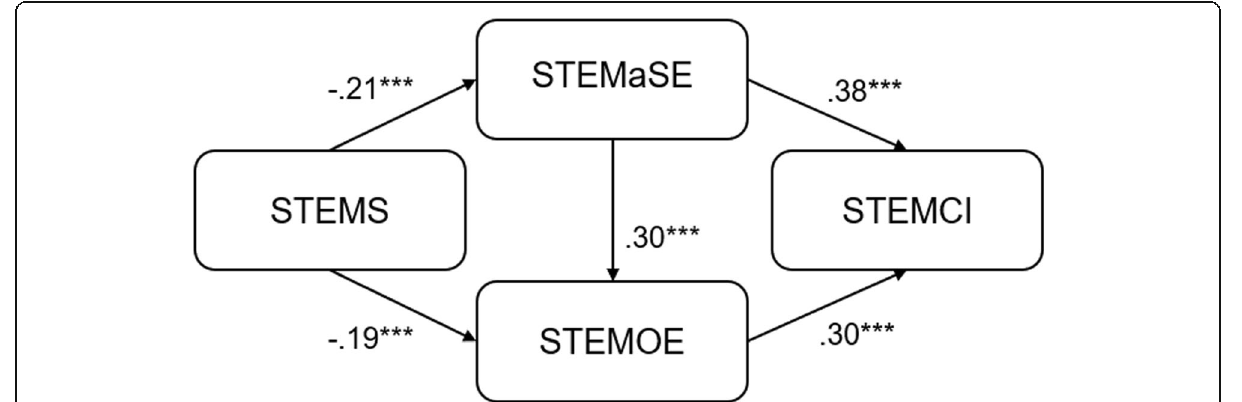
Fig. 4 Diagram and standardized path coefficients of the final SEM model (model B)